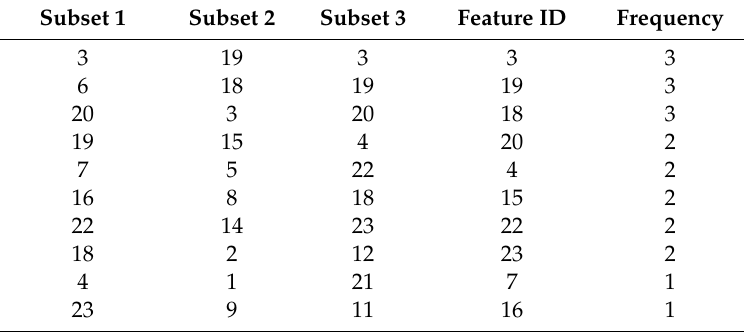
Table 3. Ensemble-2 frequency-based feature